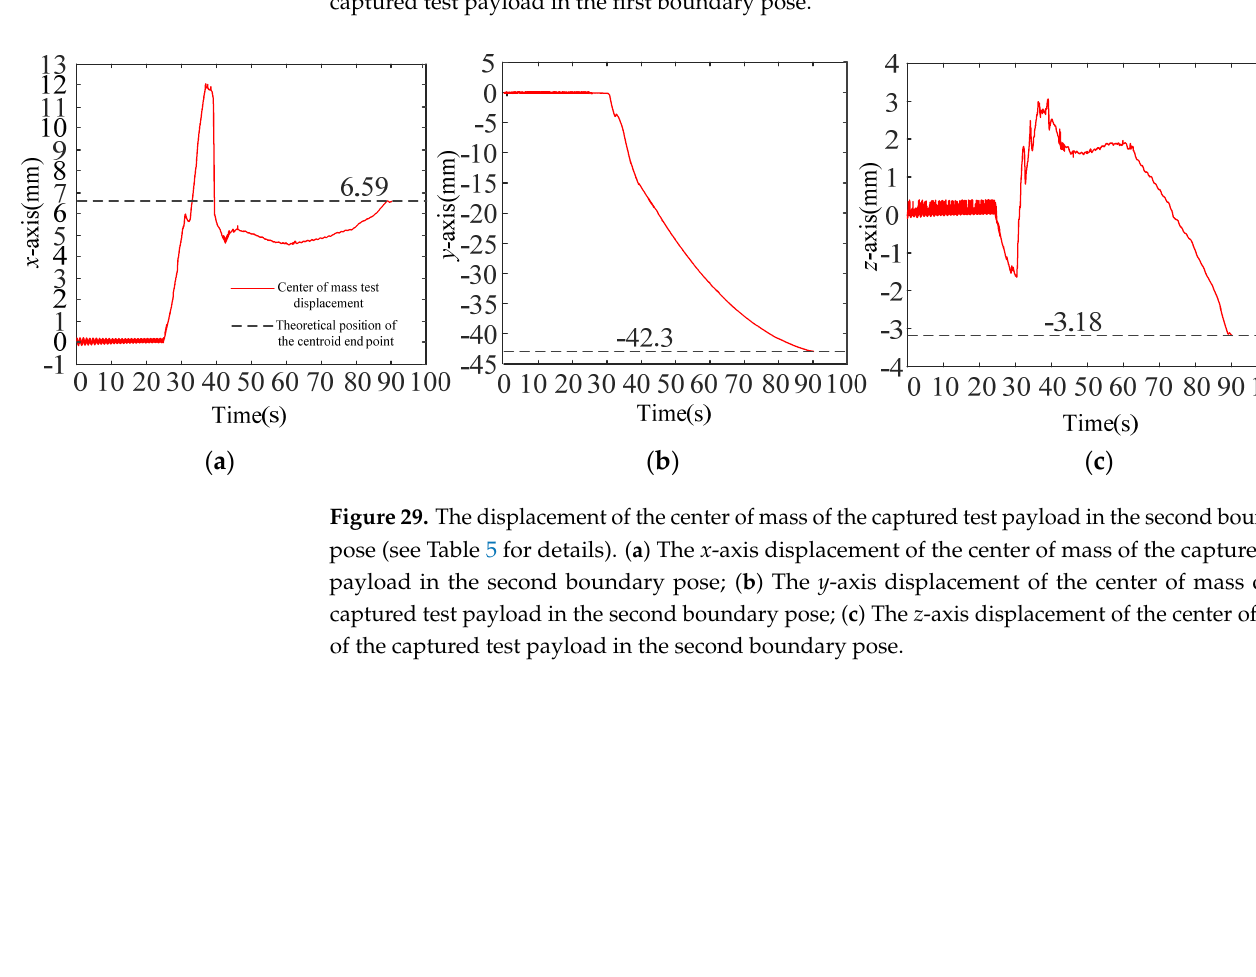
Figure 30. The displacement of the center of mass of the captured test payload in the third boundary pose (see Table 5 for details). ( a ) The x -axis displacement of the center of mass of the captured test payload in the third boundary pose; ( b ) The y -axis displacement of the center of mass of the captured